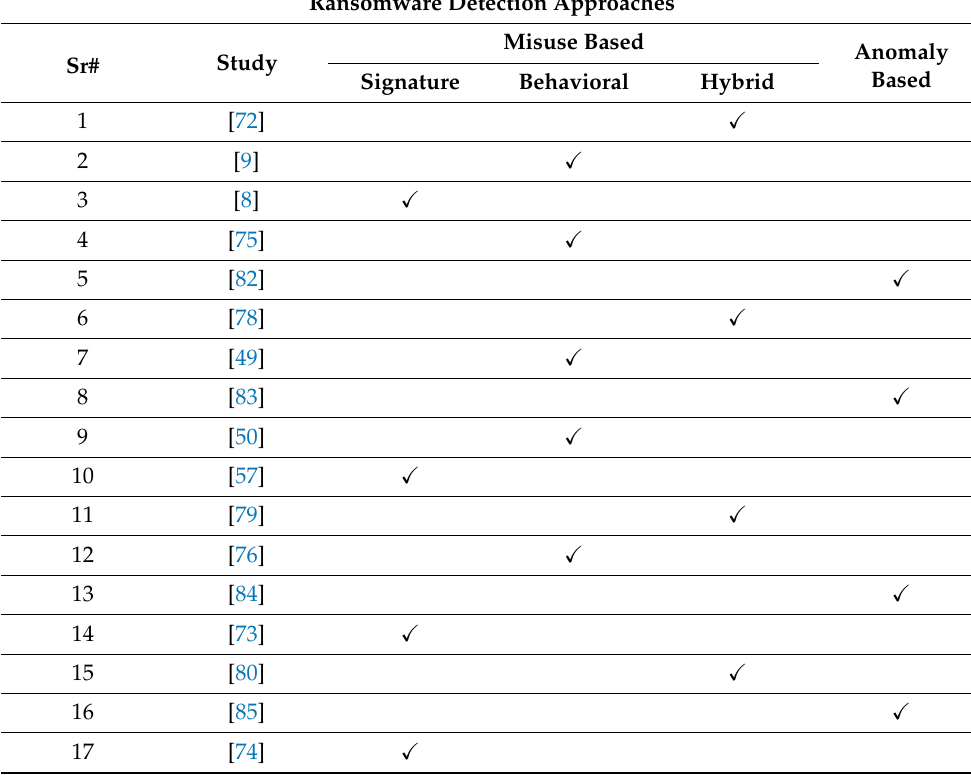
Table 1. Ransomware detection